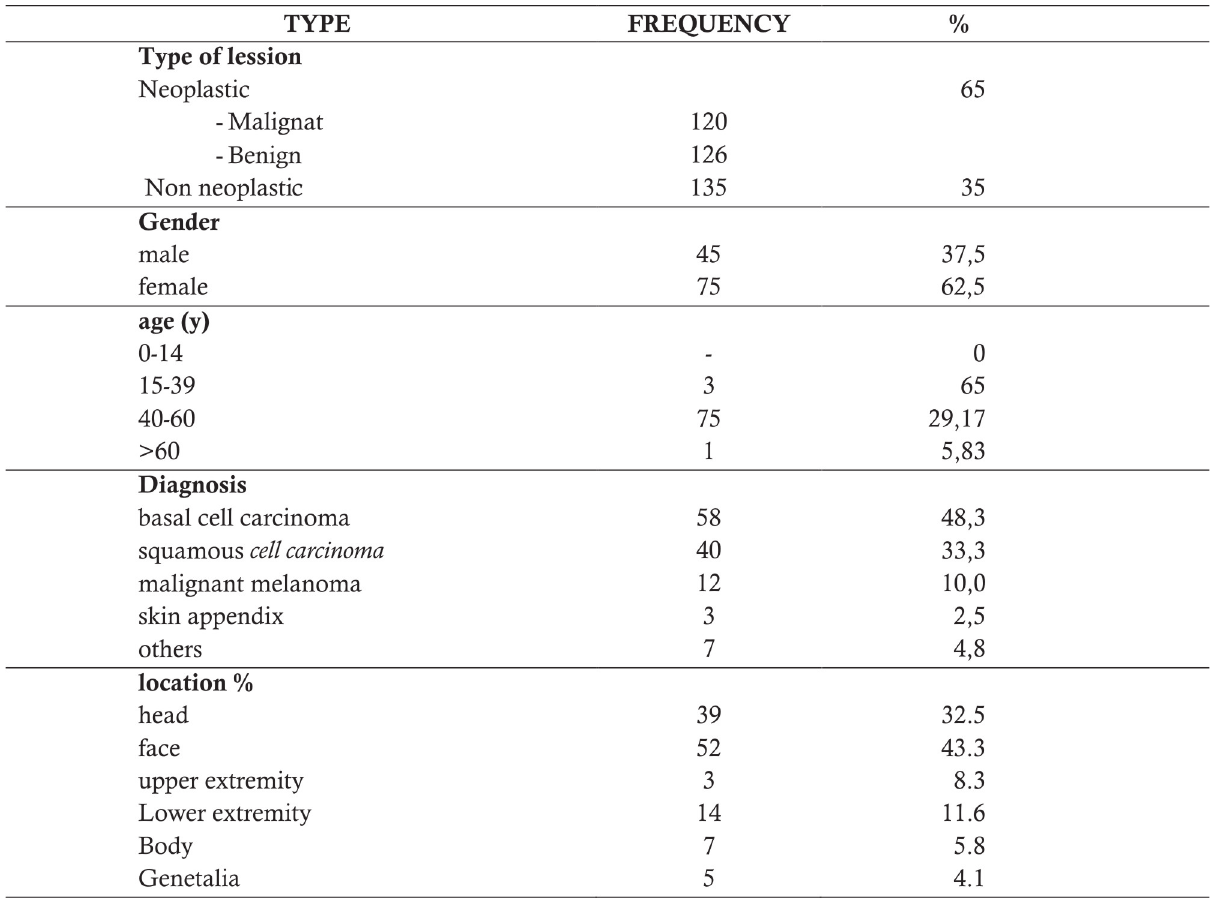
The skin specimen’s frequency of patients diagnosed in anatomy pathology laboratory in